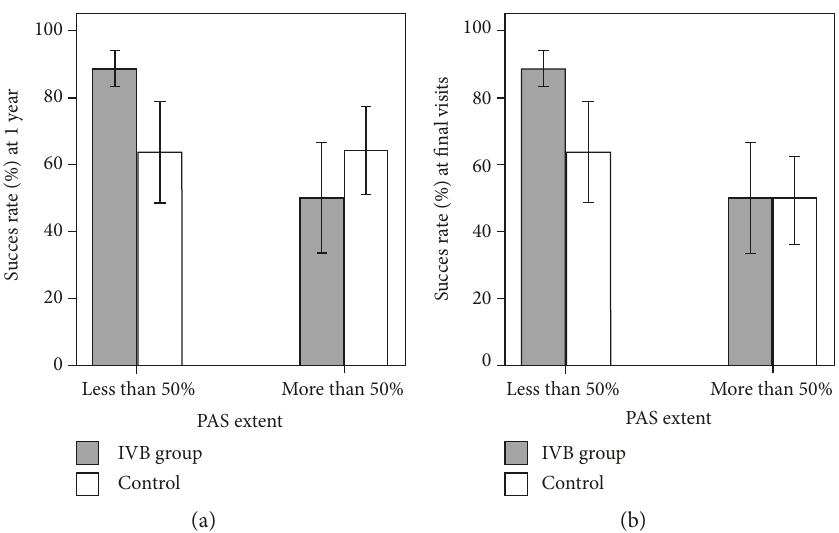
Figure 1: Graphs showing the success rates (with standard error) of glaucoma surgery, (a) at postoperative year 1 and (b) at fi nal visits, between the preoperative intravitreal bevacizumab (IVB) group and the control group, according to the extent of peripheral anterior synechiae (PAS).